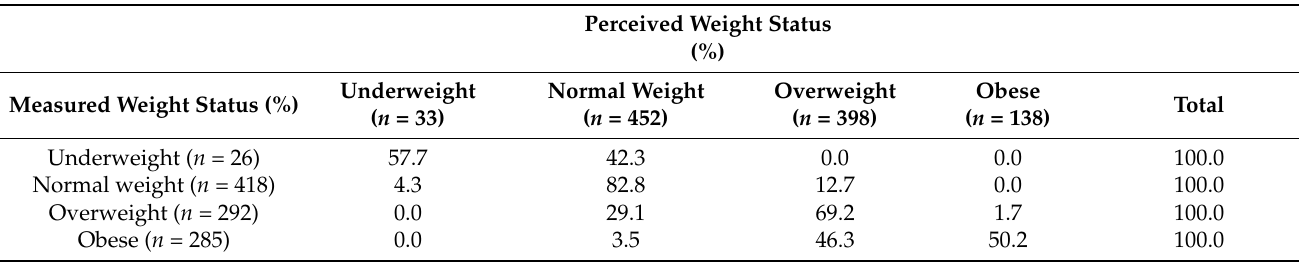
Table 3. Comparison between measured weight status and perceived weight